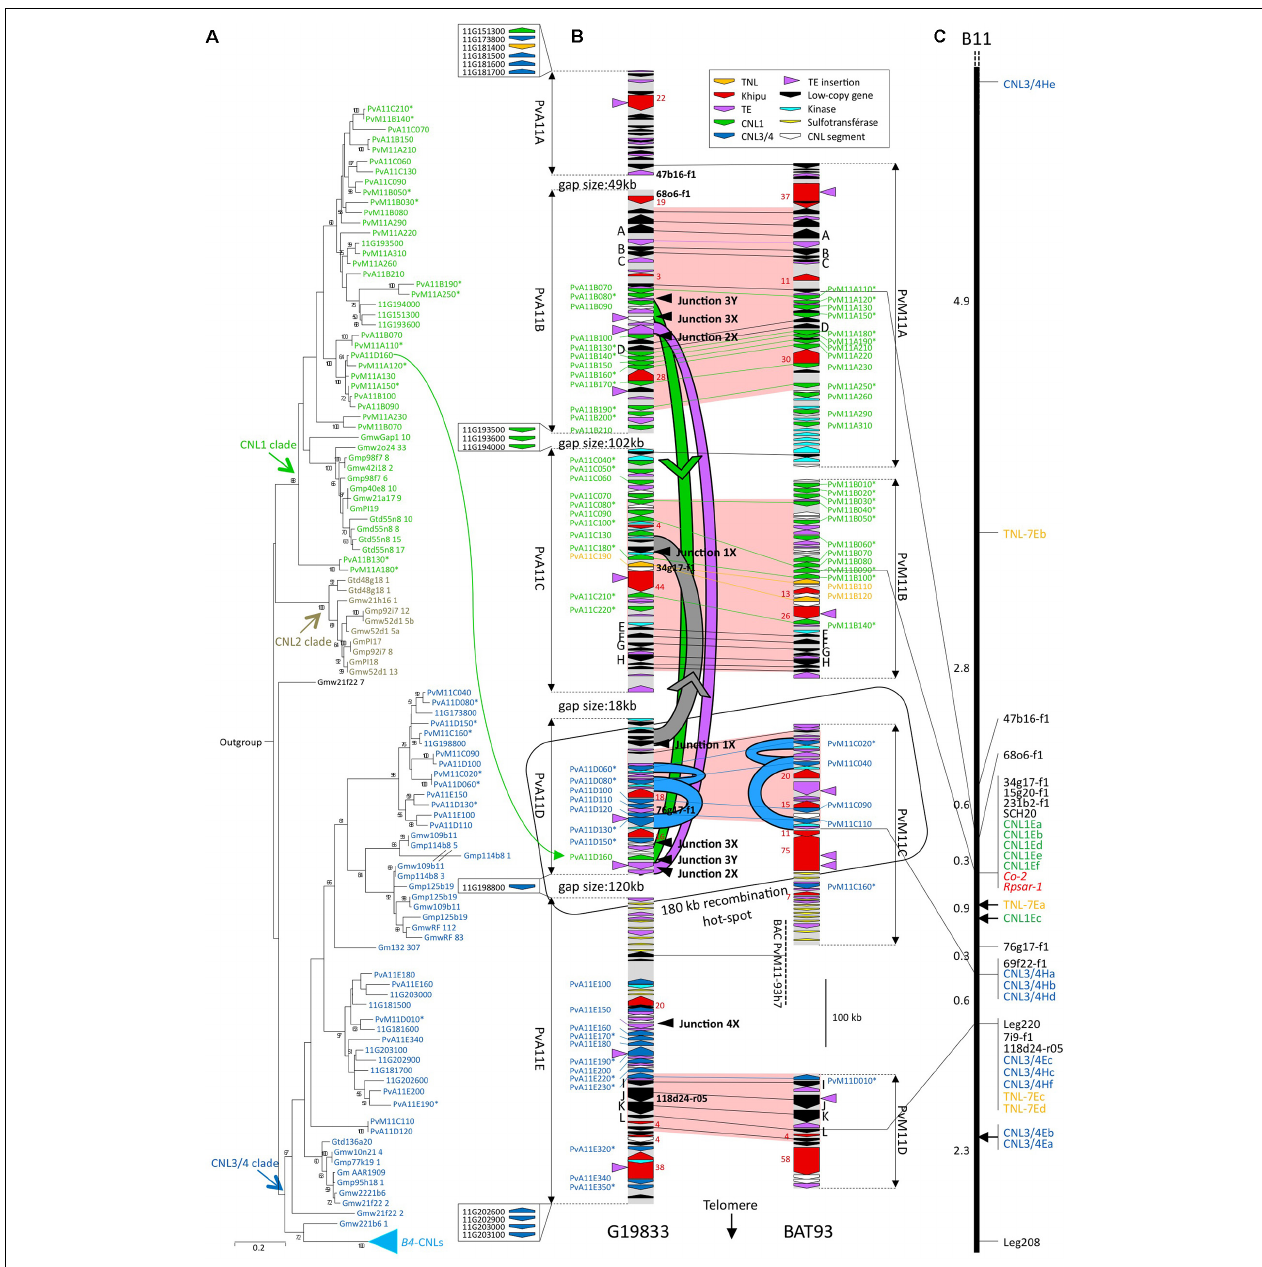
FIGURE 1 | Phylogenetic analysis, physical and genetic maps of CNL genes. (A) ML tree of CNLs of the Co-2 region. This tree was constructed using the CNL NB domains (from the P-loop to the MHD motif). Numbers at nodes indicate posterior probabilities (only > 50% are indicated). CNL names are colored according to major CNL1 (green) CNL2 (gray) and CNL3/4 (blue) clades. Gene names are abbreviated as follows: Gm, G. max ; Gt, G. tomentella ; PvA (or 11G when only found in WGS sequence) P. vulgaris Andean accession G19833; PvM, P. vulgaris Mesoamerican accession BAT93. (B) Physical map of the Co-2 region in G19833 (Andean) and BAT93 (Mesoamerican) common bean genotypes. Arrows represent predicted genes, CNL segments, or khipu blocks and their orientation. CNL names and conserved low-copy genes (A to L) are listed on the flanks. NL retrieved outside sequenced contigs in G19833 WGS sequence are represented by arrows in boxes with corresponding names, to the left of G19833 sequenced contigs (not drawn to scale). Markers used for genetic mapping (black) and number of khipu repeats in a block (red) are listed in the inside. Fill colors of CNL genes correspond to the colors of the clades defined in (A) . Horizontal lines represent alleles of low-copy (black), CNL1 (green), CNL3/4 (blue) or TNL (yellow) genes. Red-filled zones correspond to regions strictly collinear based on low-copy and CNL alleles. Curved green, gray, or blue lines represent segmental green, gray, or blue duplication events, respectively. Green and gray arrowheads indicate the putative orientation of green and gray event, respectively. The large orange arrow represents the 34 kb SD from the Co-2 cluster to chromosome 10. Black arrowheads at the right side of G19833 contigs point to corresponding junctions at the edge of segmental duplications. These junctions are detailed in Figure 4 . (C) Genetic map of the Co-2 locus (LG B11). Markers are listed on the right. Green and blue text correspond to the CNL1 and CNL3/4, respectively. Red text corresponds to resistance genes. Genetic distances between each marker are indicated on the left in Kosambi cM. An asterisk has been added at the end of CNL sequence names corresponding to pseudogenes.